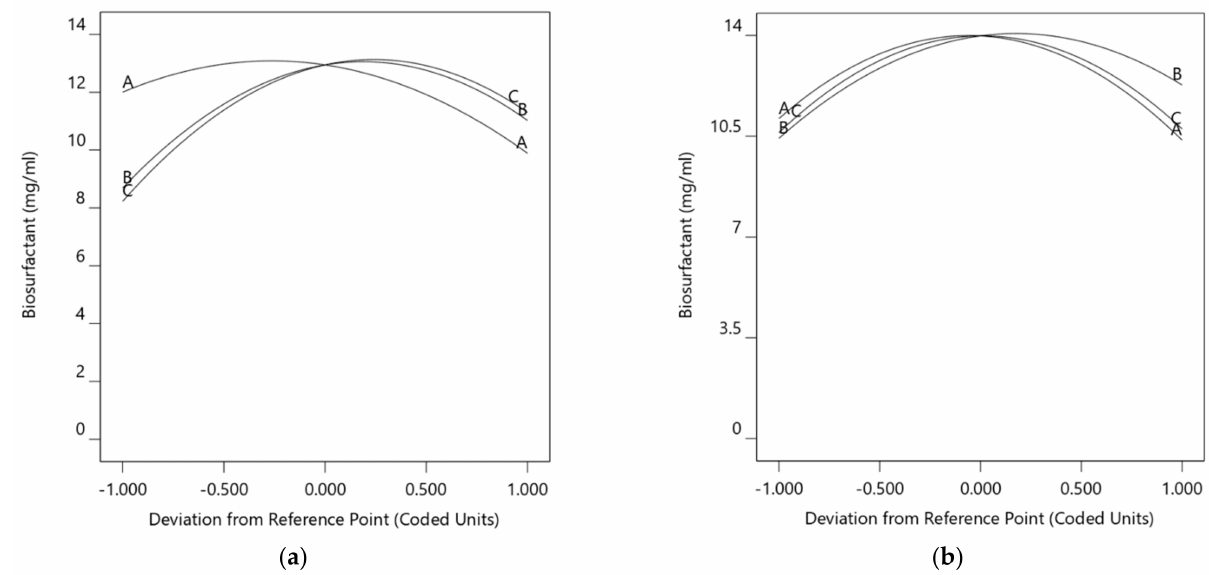
Figure 9. Perturbation plots for biosurfactant production using ( a ) WCO and ( b ) PCO as substrate.